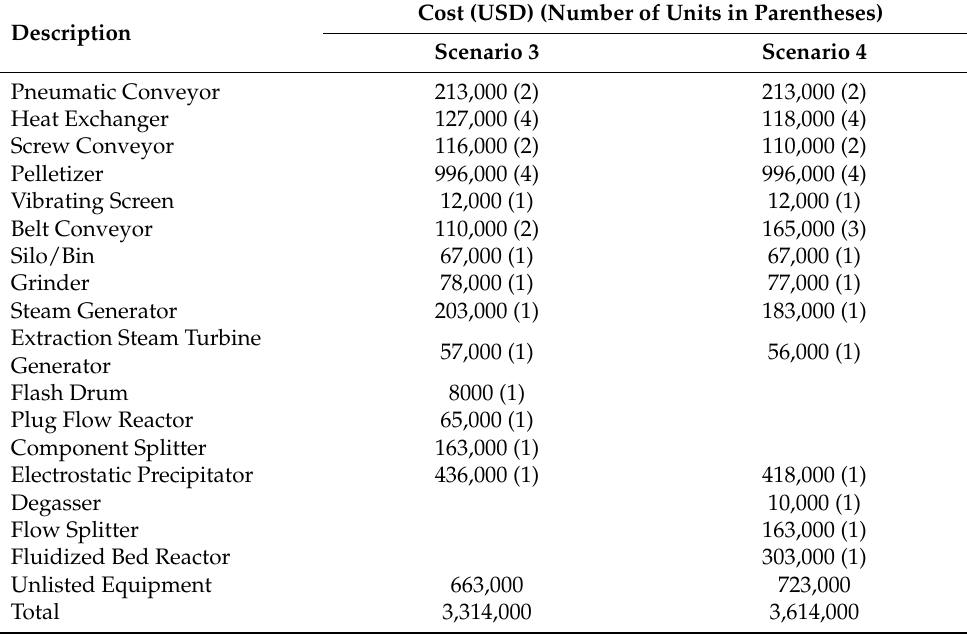
Table 2. Major equipment costs (2020 prices in USD) for Scenarios 3 and